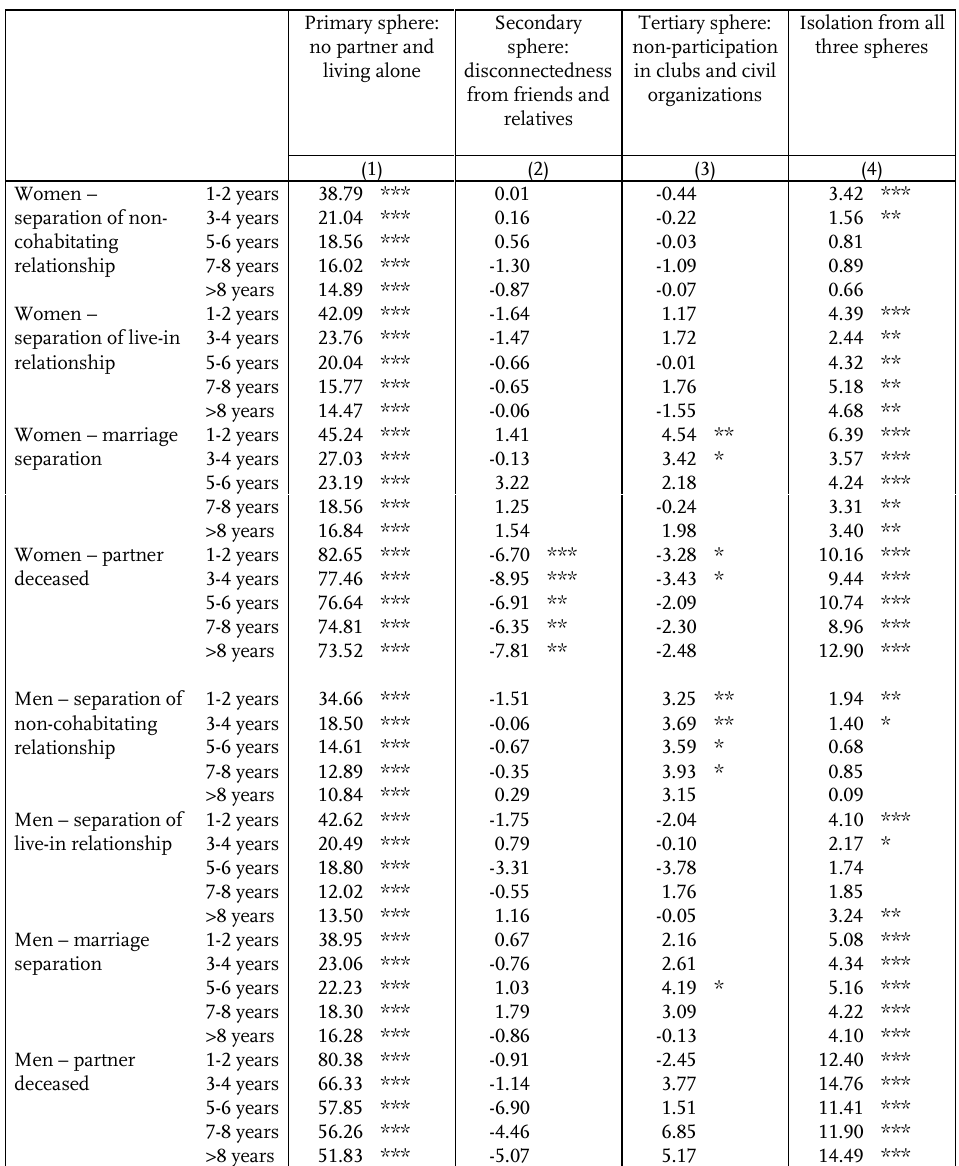
Table A.7 : Time-effects of relationship endings on different types of social isolation (from linear-probability models with fixed effects, percentage